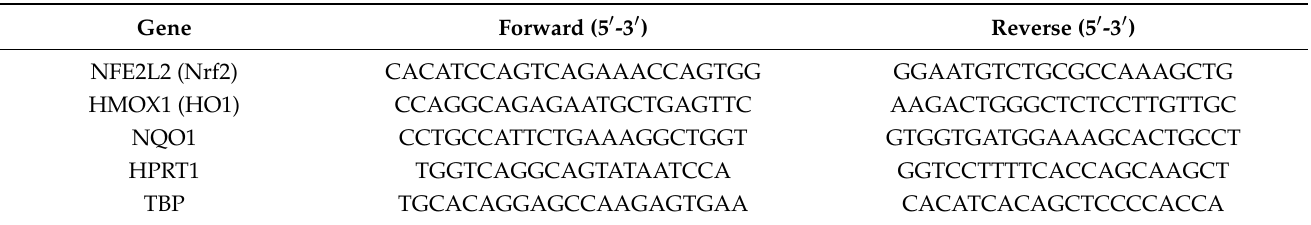
Table 1. Primer sequences used in the